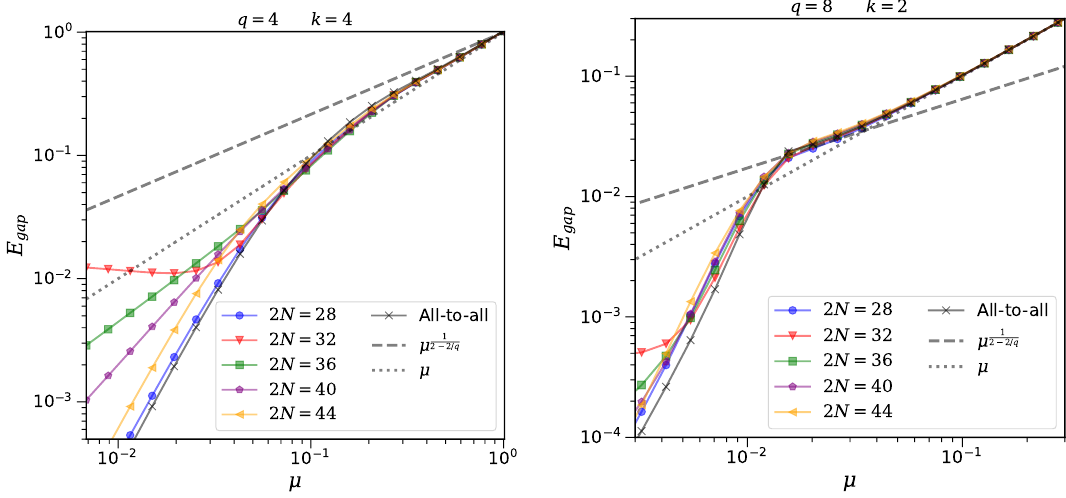
Figure 8. Energy gap of the two coupled sparse SYK system for q = 4 , k = 4 (Left) and q = 8 , k = 2 (Right). Dotted and dashed lines are the expected scalings E gap ∝ µ 1 2 − 2 /q and E gap ∝ µ at weak and strong coupling, respectively, obtained from the large N analysis. The energy gap for the two coupled all-to-all SYK model with 2 N = 28 is also included for comparison. The results correspond to an average over 50 disorder